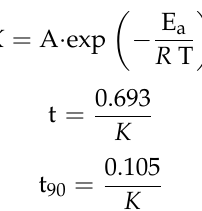
Table 5. Kinetic parameters, half-life and shelf-life obtained with Kissinger and Ozawa–Flynn–Wall methods. Method